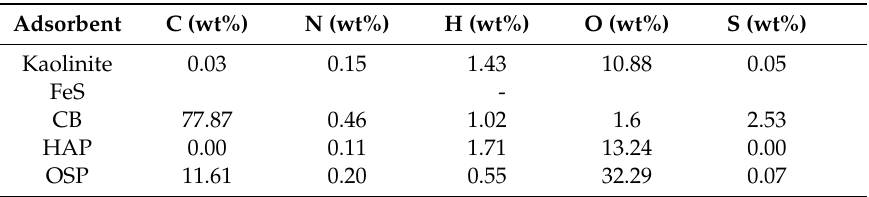
Table 2. Elemental analyses of the five test materials.